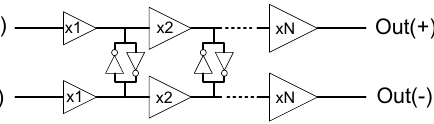
Figure 6. Cascaded CMOS digital buffers used at the oscillator